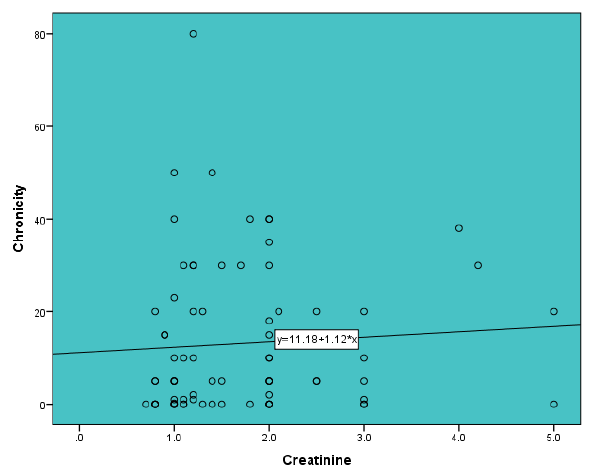
Figure 2. Correlation between serum creatinine and glomerular chronicity percent.